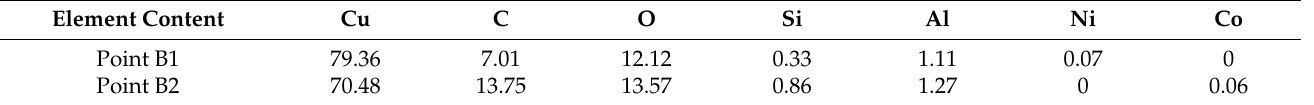
Figure 14. C17200 beryllium copper alloy fractured at 450 °C ( S max = 270 MPa, N f = 0.64 × 10 7 cycles). ( a ) General view of fatigue-fractured surface; ( b ) crack initiation region; ( c ) crack propagation region; ( d ) enlarged view of crack propagation region; ( e ) region of junction; ( f ) final rupture region; ( g ) EDS spectrum of point B1; and ( h ) EDS spectrum of point B2. Table 4. Element content of point B1 and B2 (wt. %).